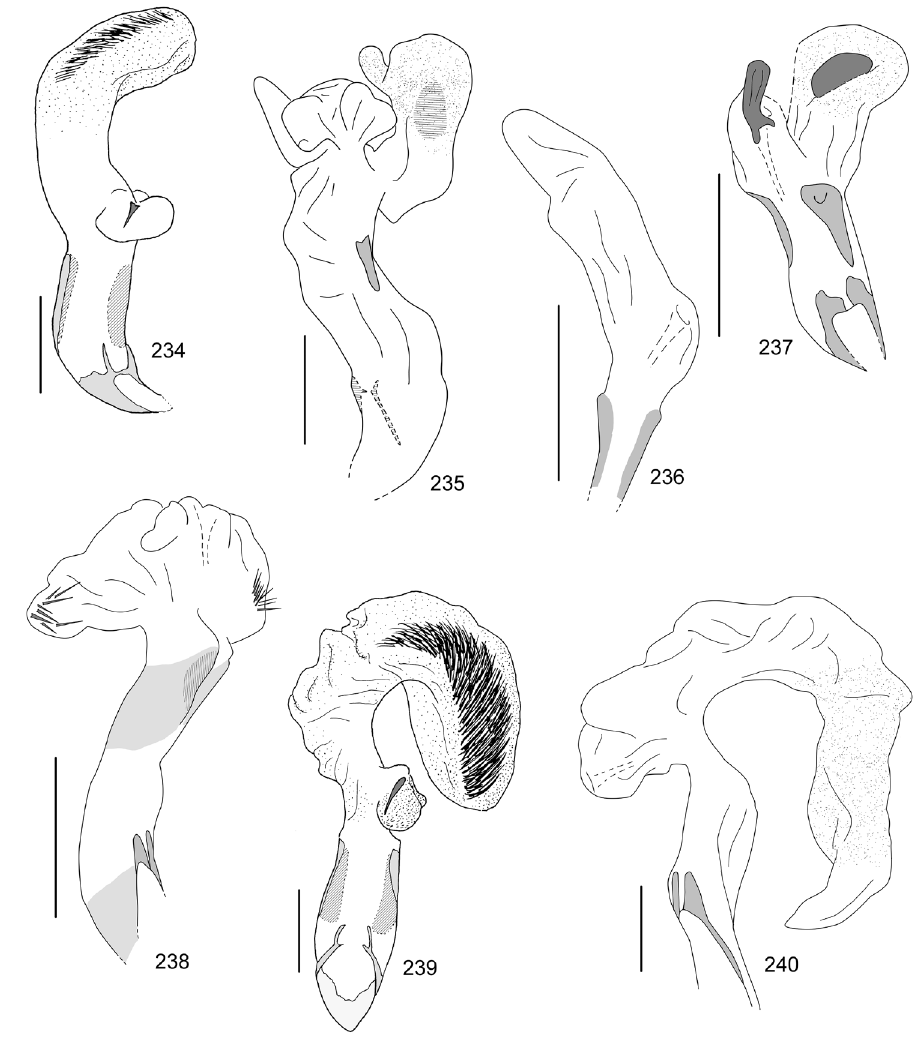
Figures 234–240. Endophallus of 234 Anomala atrivillosa (Estación Barva, Heredia, MNCR) 235 A. balzapambae (Rancho Quemado, Puntarenas, MNCR) 236 A. calligrapha (Cabro Muco, Guanacaste, CEUA) 237 A. chiriquina (Estación Biológica Las Alturas, Puntarenas, MNCR) 238 A. cinaedias (San Luis, Puntarenas, MNCR) 239 A. clarivillosa (La Esperanza del Guarco, Cartago, CEUA) 240 A. clathra- ta (Albergue Heliconias, Alajuela, CEUA). Scale bars: 1 mm. Figs 234, 239 from Filippini et al.